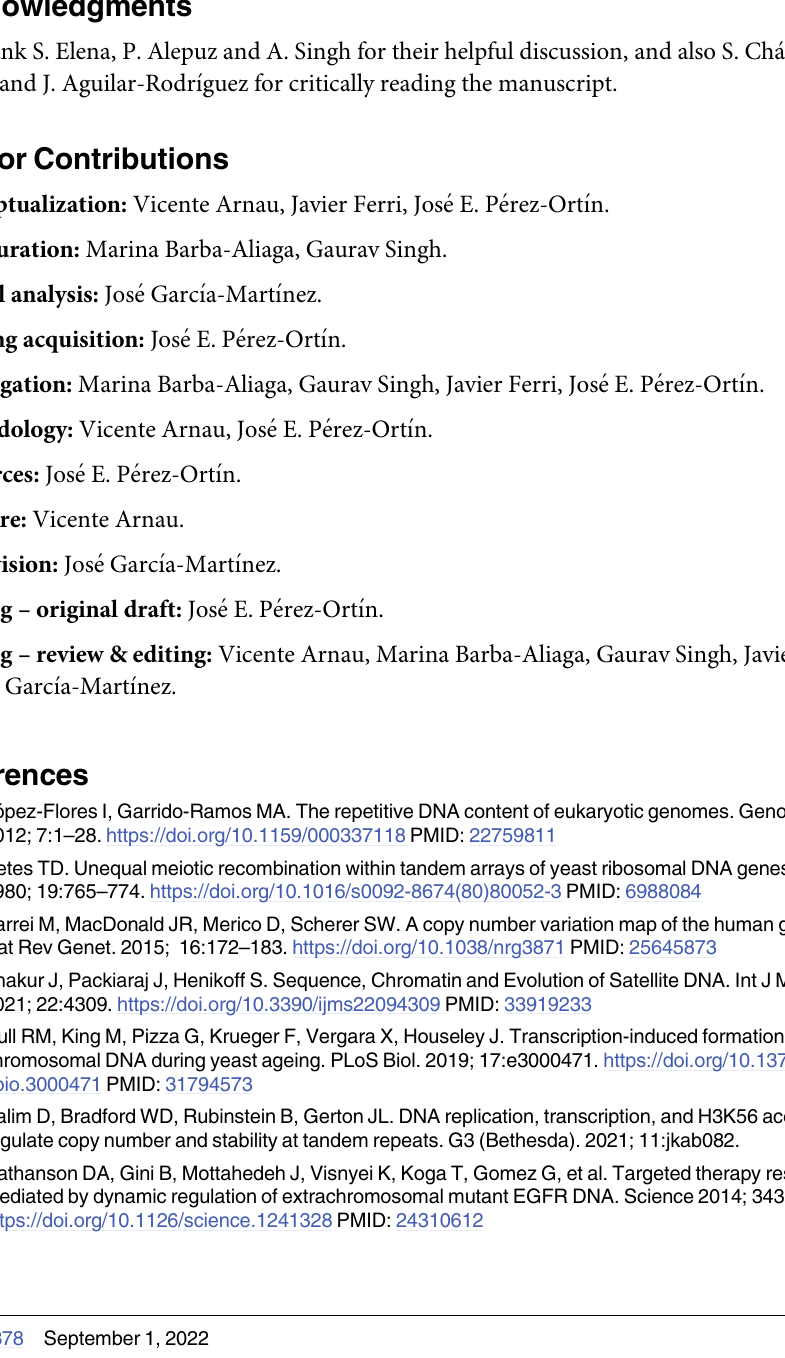
S1 Table. List of the yeast strains used in this work.